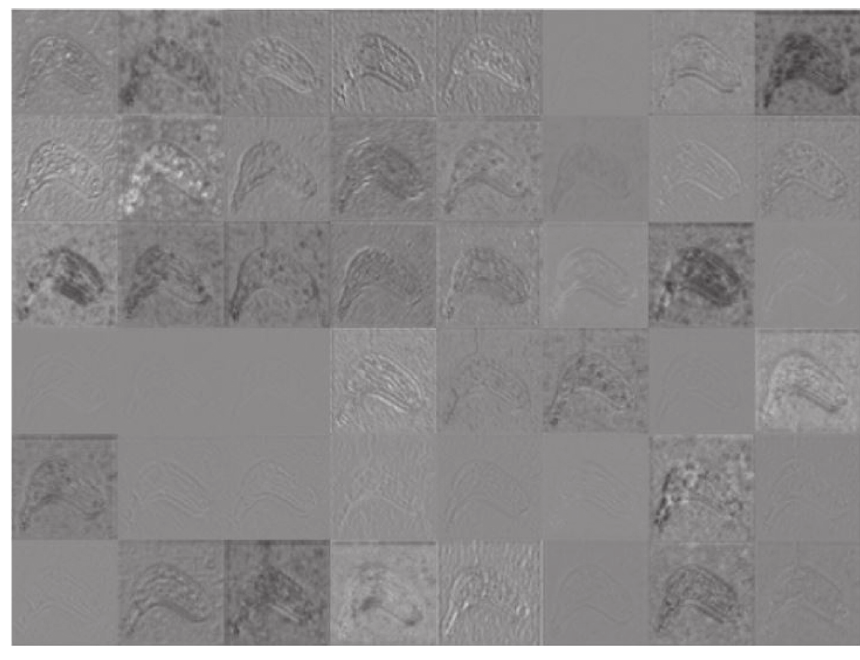
Figure 9: Learned features of a deeper convolution layer